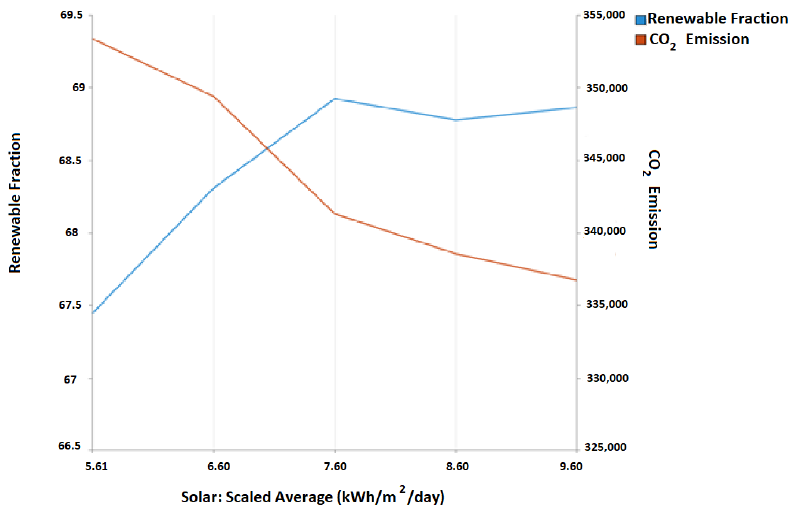
Figure 11. Sensitivity analysis of renewable fraction and CO 2 emissions based on average solar radiation.